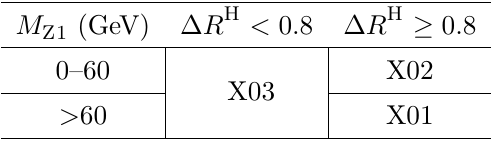
Table 11 . Definition of the search regions for events with 4 leptons with one or more t two light-lepton OSSF pairs